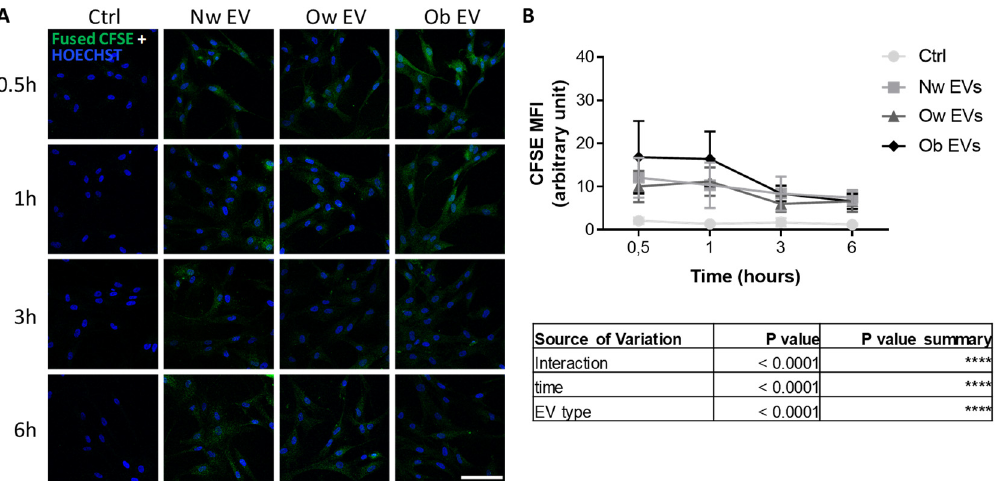
Figure 2. ( A ) Confocal microscopy analysis of MSC treated for 0.5, 1, 3 and 6 h with CFSE + EVs from participants with normal weight (Nw), overweight (Ow) and obesity. Pictures show the resultant recipient cells as proof of EV uptake. Nuclei were stained with Hoechst (blue). Scale bar: 100 μ m. ( B ) Mean fluorescence intensity (MFI) quantification of CFSE + MSCs following the treatment with CFSE + EVs. The table below shows the results from ANOVA 2-way analysis.